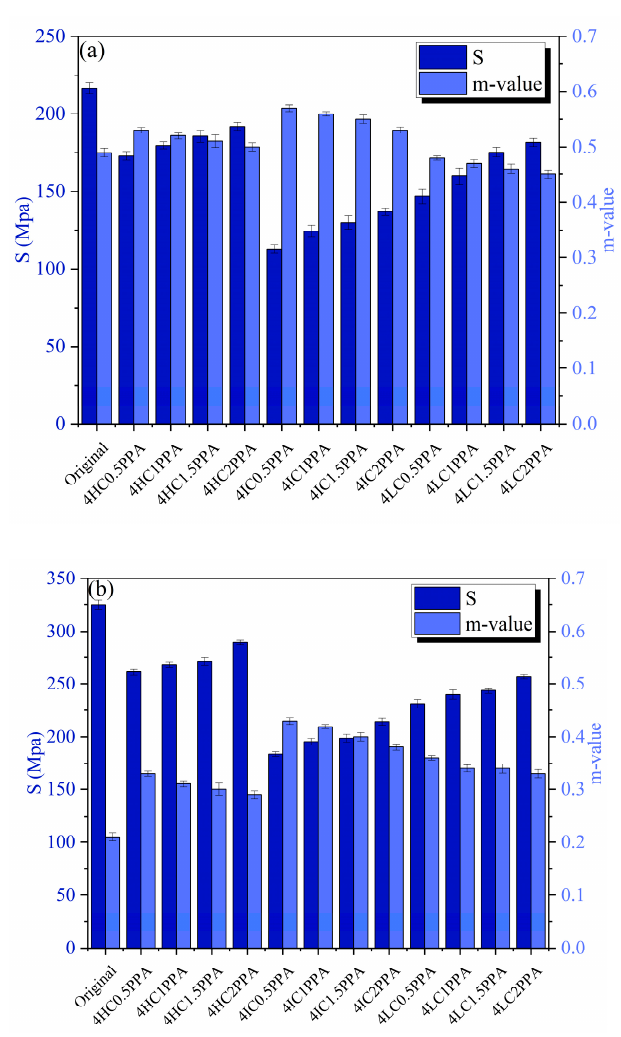
Figure 9. The S and m-value results of modified bitumen: ( a ) − 12 ℃ ( b ) − 18 ℃ .